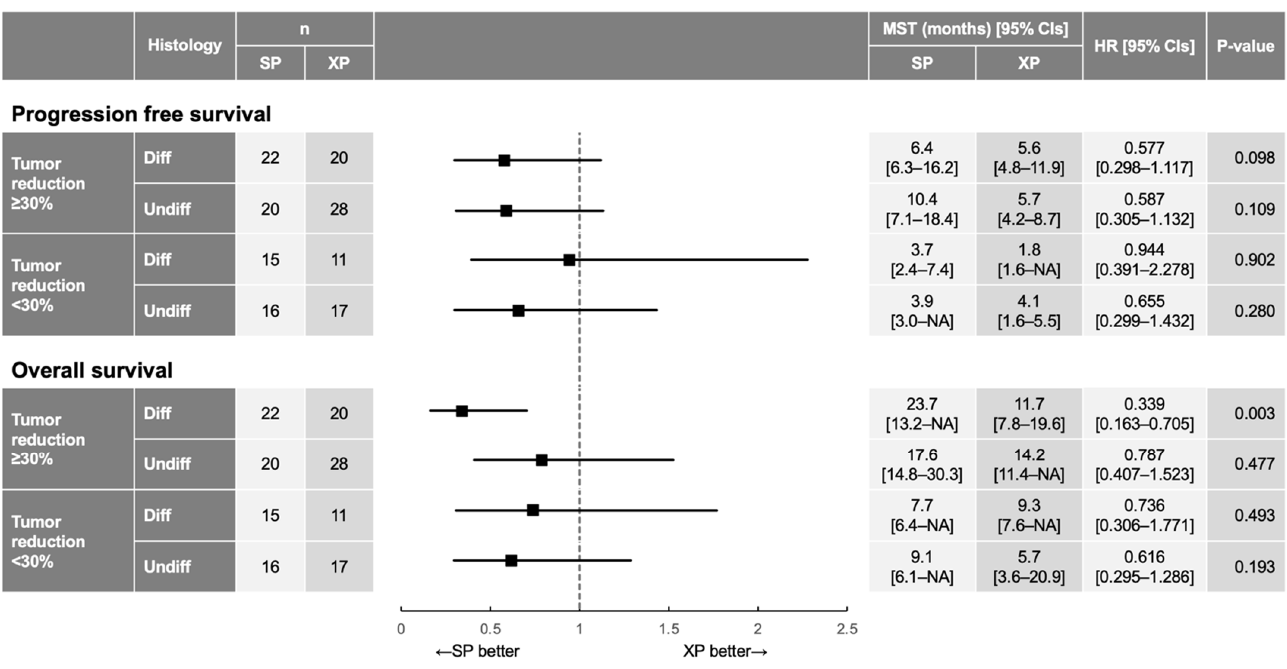
Figure 5. HR and 95% CI for PFS and OS in patient subgroups defined by the extent of tumor reduction and tumor histology. The p values were determined with the log-rank test. MST, median survival time; NA, not available.